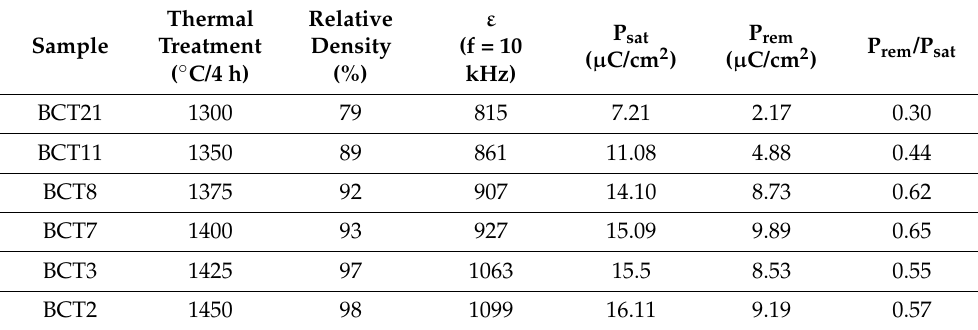
Table 1. Sample notation and dielectric and ferroelectric room temperature characteristics